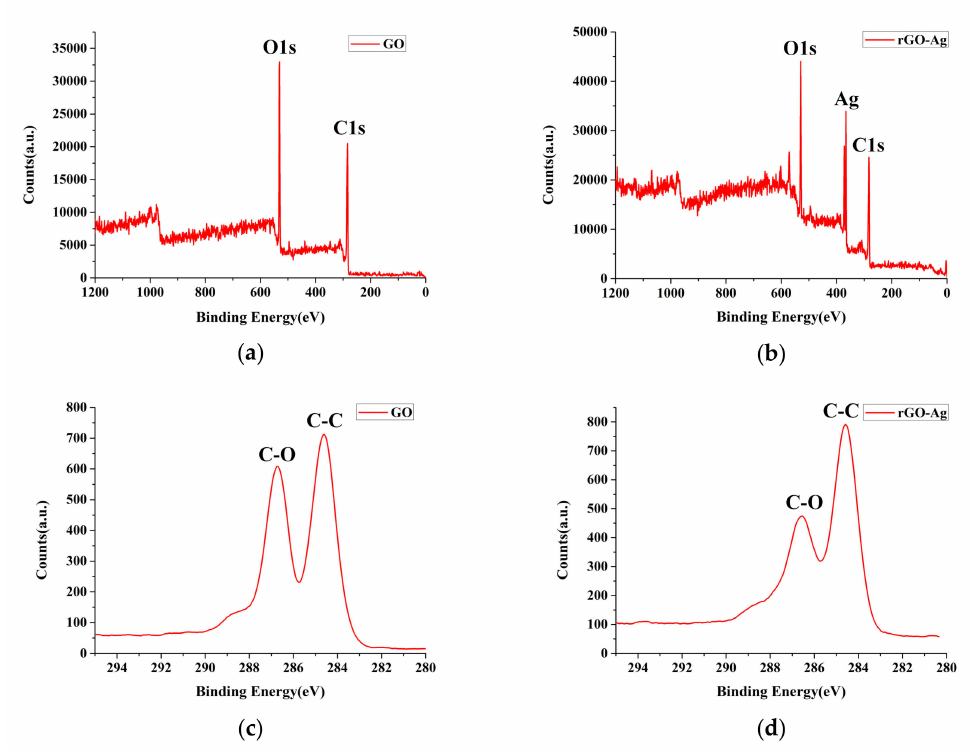
Figure 9. X-ray photoelectron spectroscopy (XPS) spectrum ( a ) survey spectrum of GO; ( b ) survey spectrum of rGOAg; ( c ) C1s spectrum of GO; ( d ) C1s spectrum of